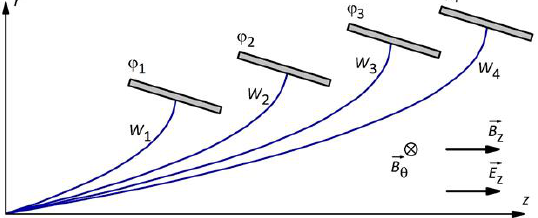
Fig. 1. Schematic drawing of electron separation in the crossed axial electric and azimuthal magnetic fields (initial electron velocity v 0  B